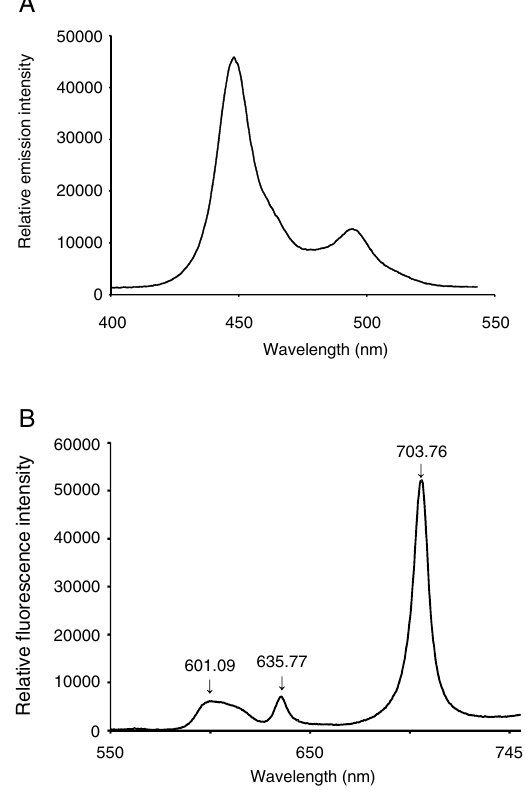
Figure 1. ( A ) Relative spectral emission curve from LED and ( B ) relative spectral fluorescence of PpIX with blue light